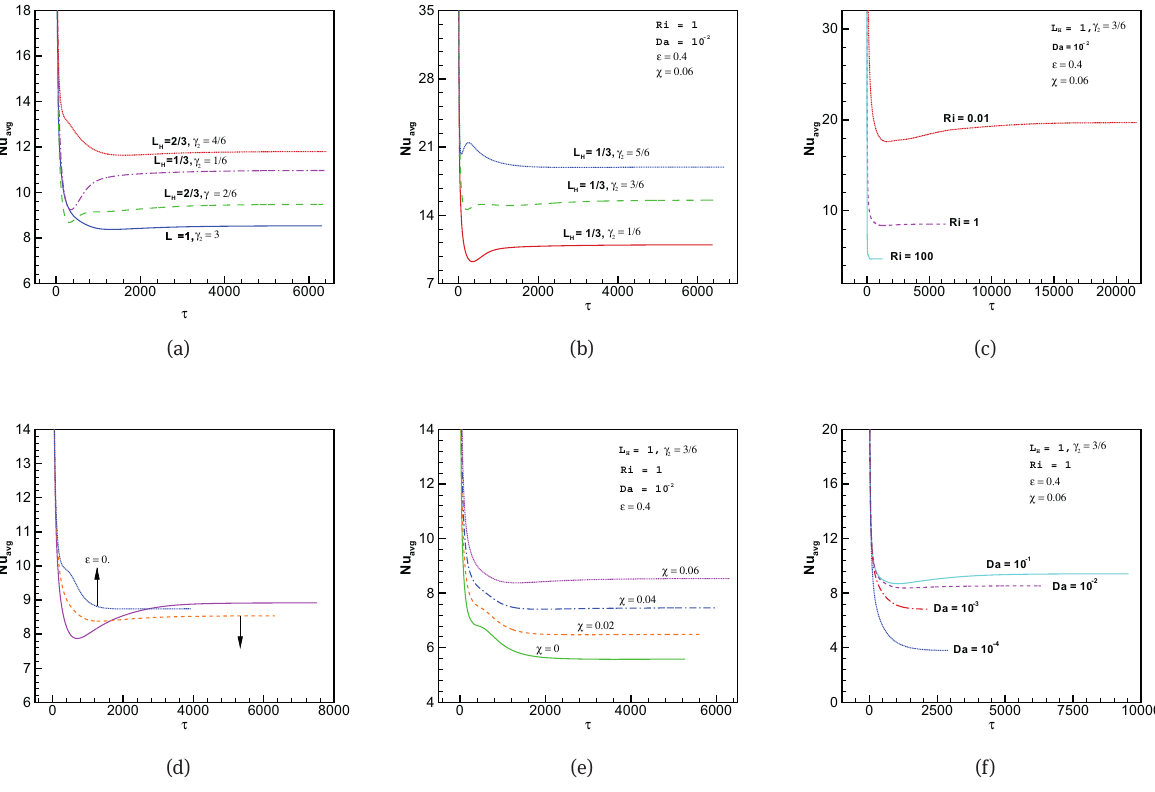
Fig. 10: Time history of average Nusselt numbers for different (a-b) L H and γ 2 , (c) Ri , (d) ϵ , (e) χ , and (f) Da .